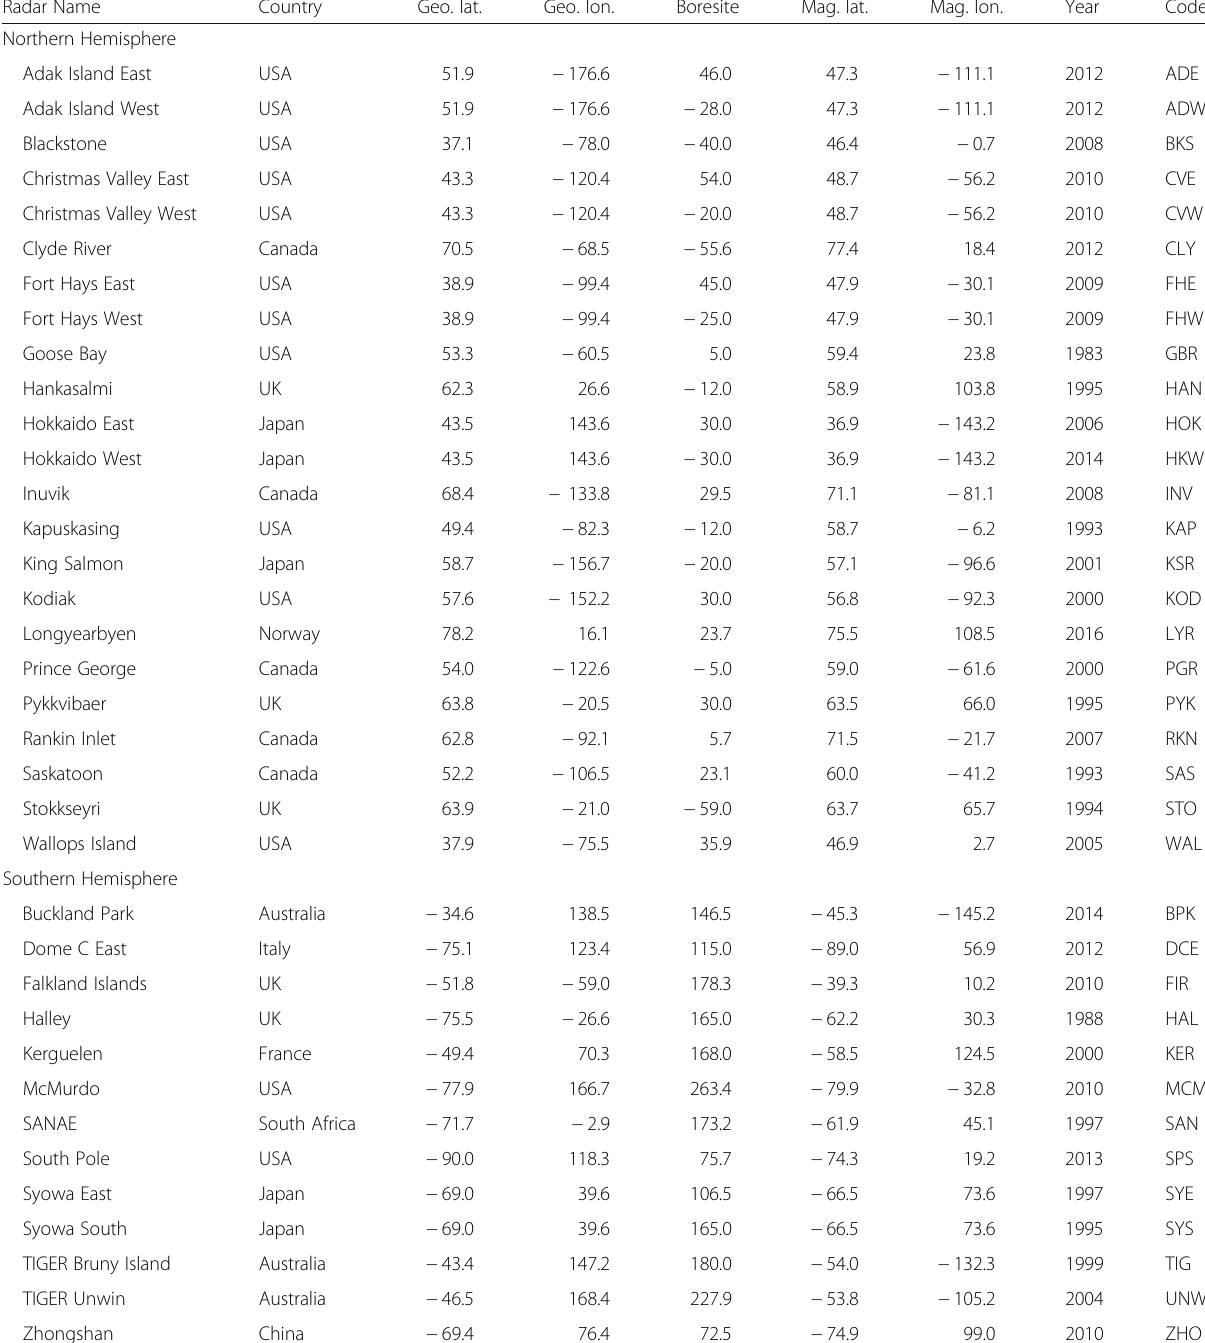
Table 1 List of SuperDARN radars. Magnetic latitudes/longitudes are in AACGM-v2 coordinates to one decimal point accuracy for